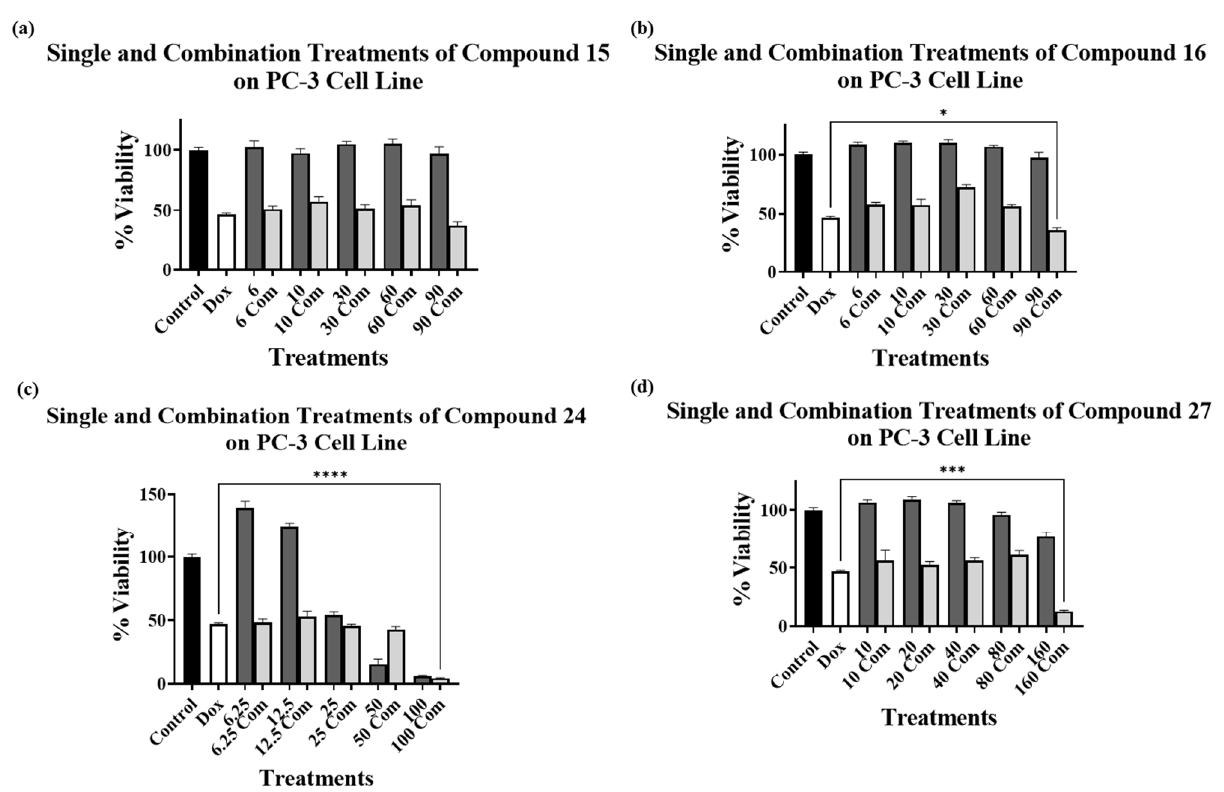
Figure 4. Cell viability assays using compounds ( a ) 15 , ( b ) 16 , ( c ) 24 , and ( d ) 27 alone at various concentrations (dark grey bars) and in combination with 1 µ M DOX (light grey bars) on PC-3 cell line. Control bar chart (black bar) means no treatments were added. DOX at 1 μ M alone is presented as a white bar. Experiments were performed in triplicates in three independent experiments with controls (* p < 0.05, *** p < 0.001, and **** p < 0.0001).